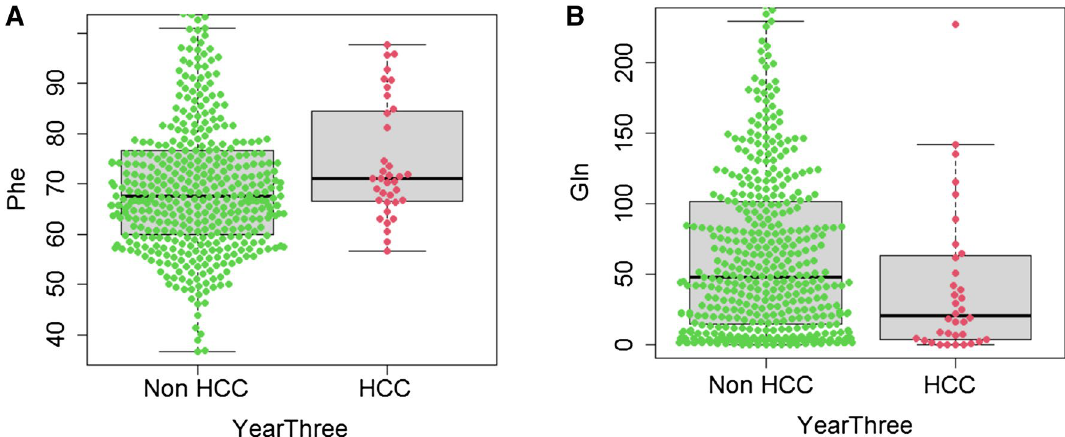
Figure 3. Box-and-Whisker plots overlaid with the Phe and Gln concentrations (μM) in patients who have or have not developed HCC at the third year. ( A ) The distribution of Phe concentrations (Mann–Whitney P = 0.033, non-HCC N = 435, HCC N = 36, censored N = 4). ( B ) The distribution of Gln concentrations (Mann– Whitney P =